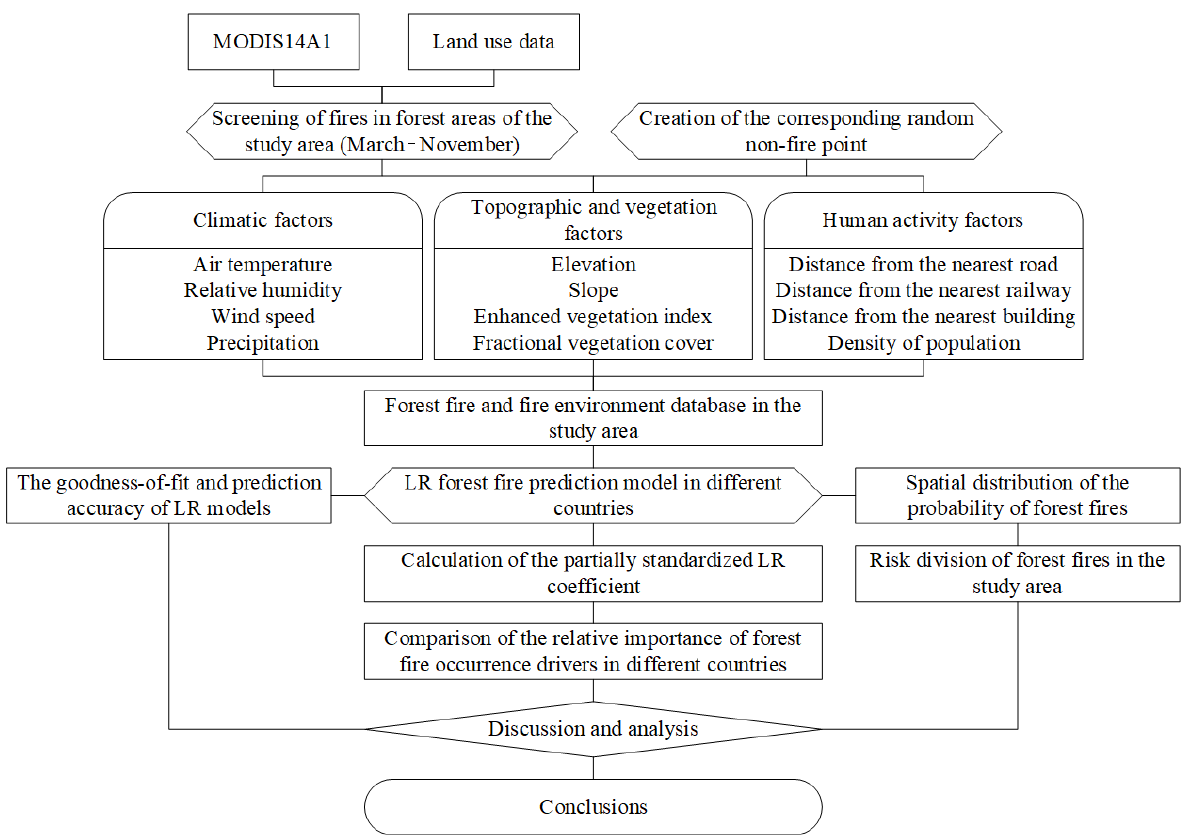
Figure 2. The overall technology roadmap of this